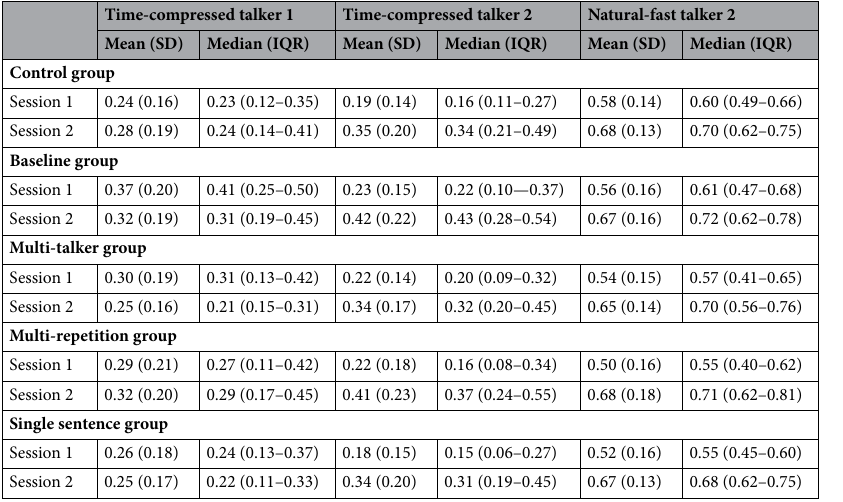
Table 5. Time-compressed speech and natural-fast speech by exposure condition and